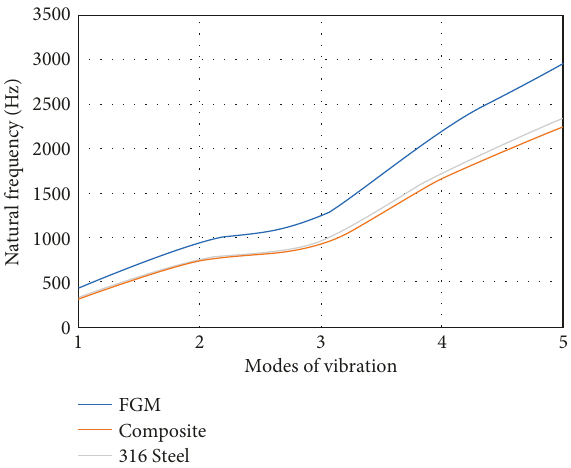
Figure 24: Natural frequencies of the 316 steel, composite, and FGM